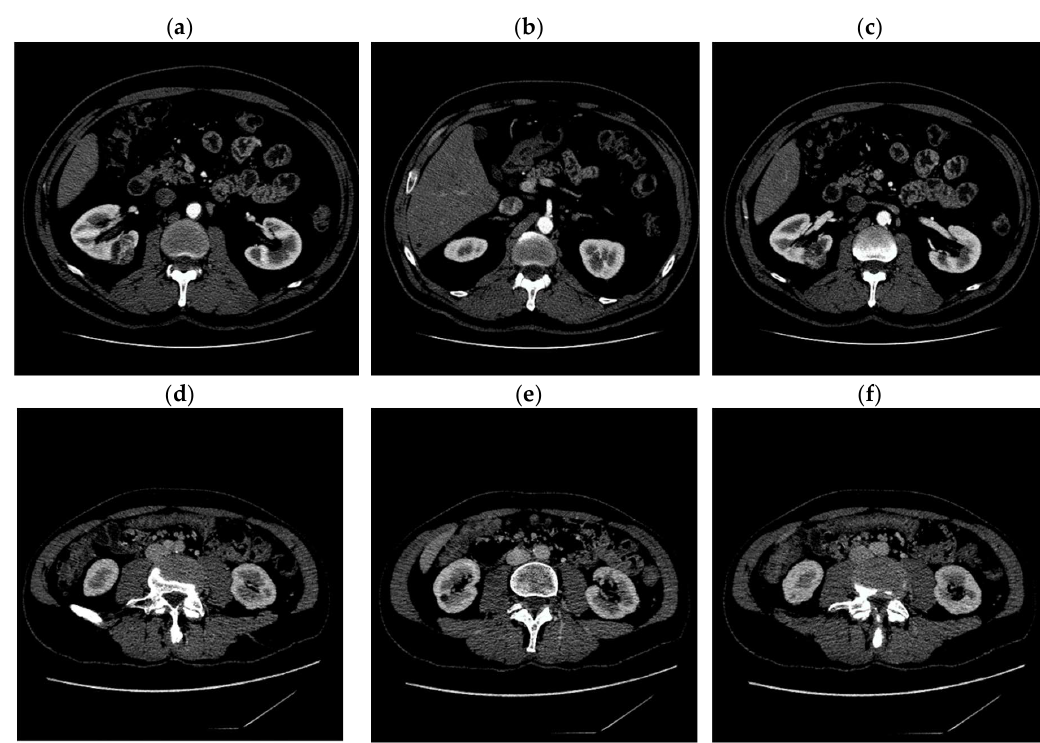
Figure 1. The figure shows six different slices obtained from a computed tomography (CT) scan after contrast media application. In examples a and b, an infiltration of the neoplastic type is visible. The shape and size of the kidneys vary considerably. Examples ( a – c ) come from the same patient, the same examples ( d – f ) show the same kidney but on different sections.